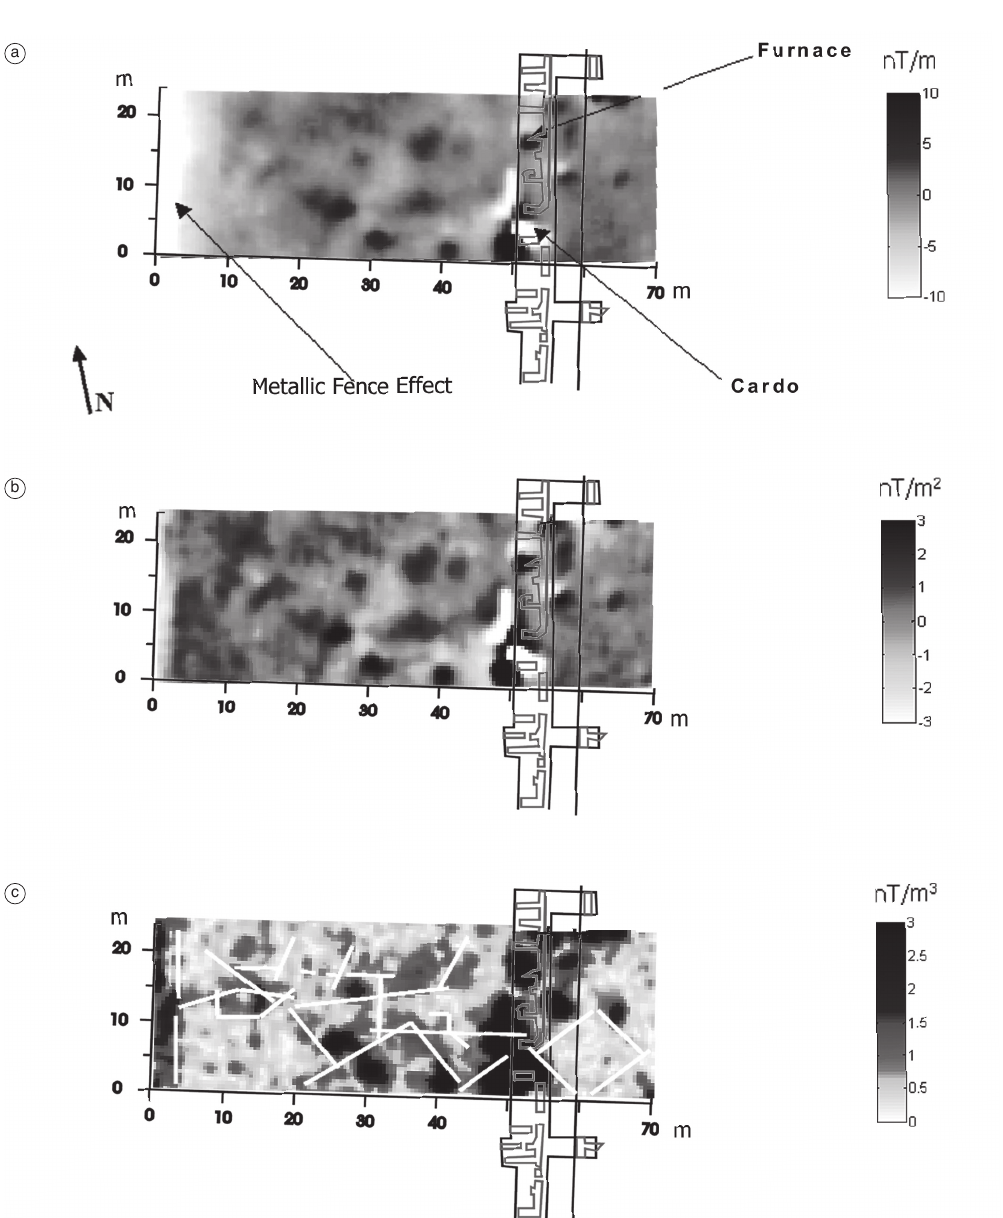
Fig. 3a-c. Map of the gradient of the magnetic field measured in a sector of 25 × 70 m 2 of the Park between two minor excavations a) Second vertical derivative of the magnetic field b) The metallic fence effect is reduced thanks to the numerical derivation and a more detailed pattern of the main anomalies is also observed. Analytical signal c) of the second vertical derivative of the magnetic field. The metallic fence effect is even more reduced, due to a further numerical derivation. White bold lines indicate highs linked to the main